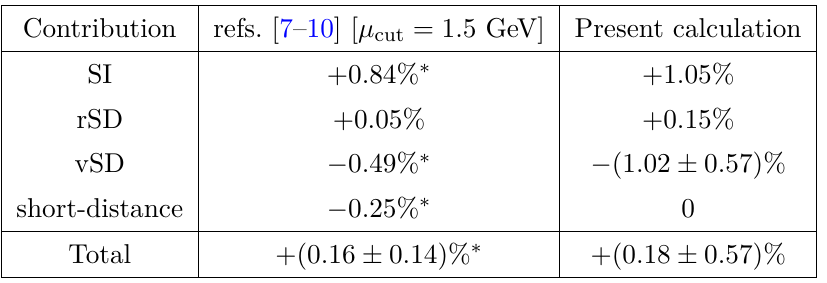
. Figures with an asterisk are cutoff- Table 3 . Comparison of photonic contributions to δR τ/π dependent, with µ = 1 . 5 GeV [7–10]. The quoted error in the radiative correction of refs. [7–10] cut arises from uncertainties in hadronic parameters of SD contributions and from variations in the cutoff parameter, µ cut